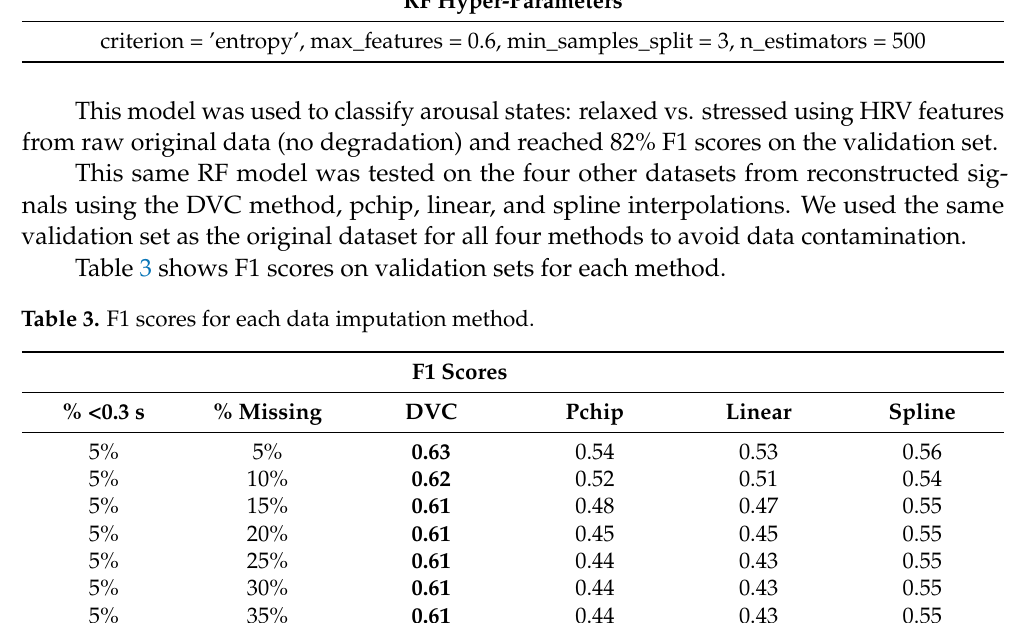
RF Hyper-Parameters